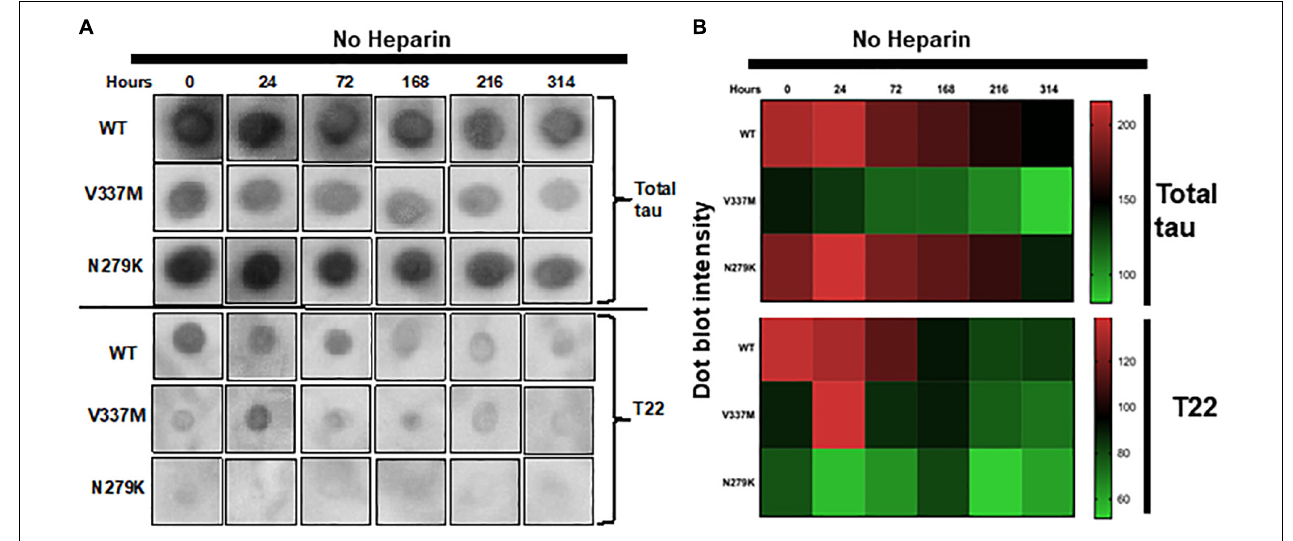
FIGURE 4 | The FTD mutations change the immuno-reactivity of tau K18. (A) Dot blots of K18-WT and its FTD variants aggregating in heparin-free conditions probed with two different tau antibodies; total tau (A0024 from Dako) and the oligomer-preferring T22. The dot blot data shown here were from identical experiments, with uncropped images shown in Supplementary Figure S2 . (B) Semi-quantification of dot blot intensity using heat